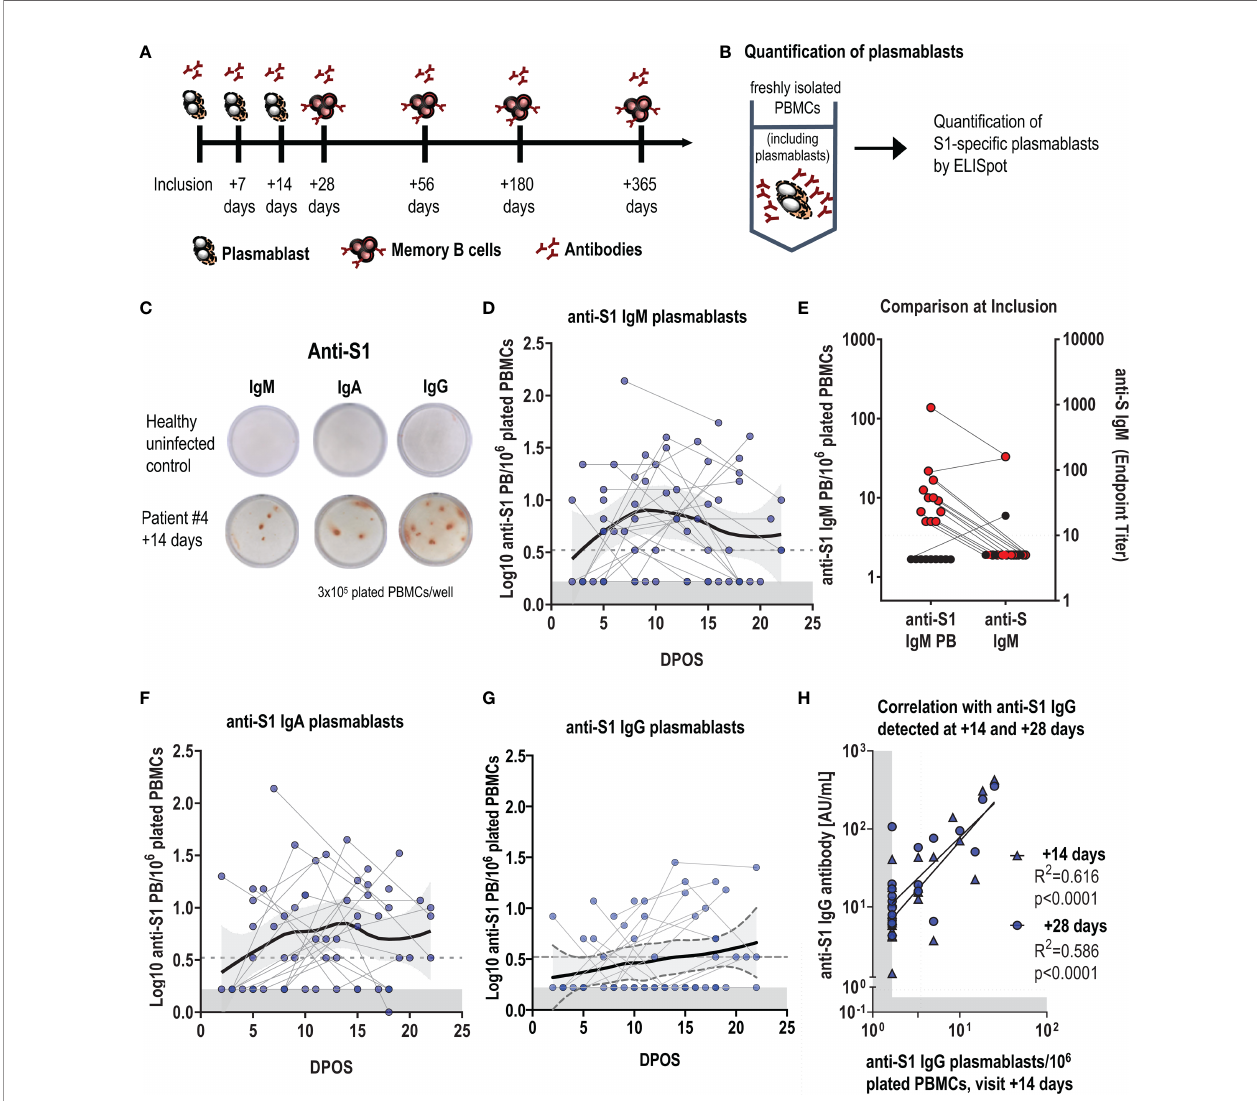
FIGURE 1 | Early plasmablast responses following SARS-CoV-2 infection correlate with antibody titers. (A) Schematic of the timepoints following infection when blood samples were collected for the assessment of SARS-CoV-2 speci fi c plasmablast, antibody and memory B-cell responses. (B) Experimental design for the quanti fi cation of S1-speci fi c plasmablasts (PBs) from fresh blood by ELISpot, with (C) representative ELISpot wells of a healthy control (top) and an infected patient (#4) at visit +14 days (bottom). 3x10 5 fresh PBMCs were plated per well, and each red spot corresponds to one S1-speci fi c IgM, IgA or IgG- secreting plasmablast. (D, F, G) Log-transformed number of S1-speci fi c PBs per million plated PBMCs for IgM, IgA and IgG, depending on the days post-onset of symptoms (DPOS). Each dot connected by a line corresponds to one patient and positive data points were fi tted using LOESS regression with the 95% con fi dence interval. Limit of detection are 3,2 PBs per 1 million plated cells, and the grey area indicates levels in healthy controls (n=10). (E) shows at the fi rst visit (inclusion) the presence of S1-speci fi c IgM plasmablasts and concomitant measured rIFA anti-S IgM antibody titres in the blood. Results from the same individual are connected with a line. (H) Correlation between log-transformed anti-S1 IgG plasmablasts at visit +14 days and log-transformed anti-S1 IgG antibody levels at the same (+14 days) and the following visit (+ 28 days). Dotted line represents the cut-off of the assay, the grey area indicates the detection limit, calculated as 50% of the cut-off of the